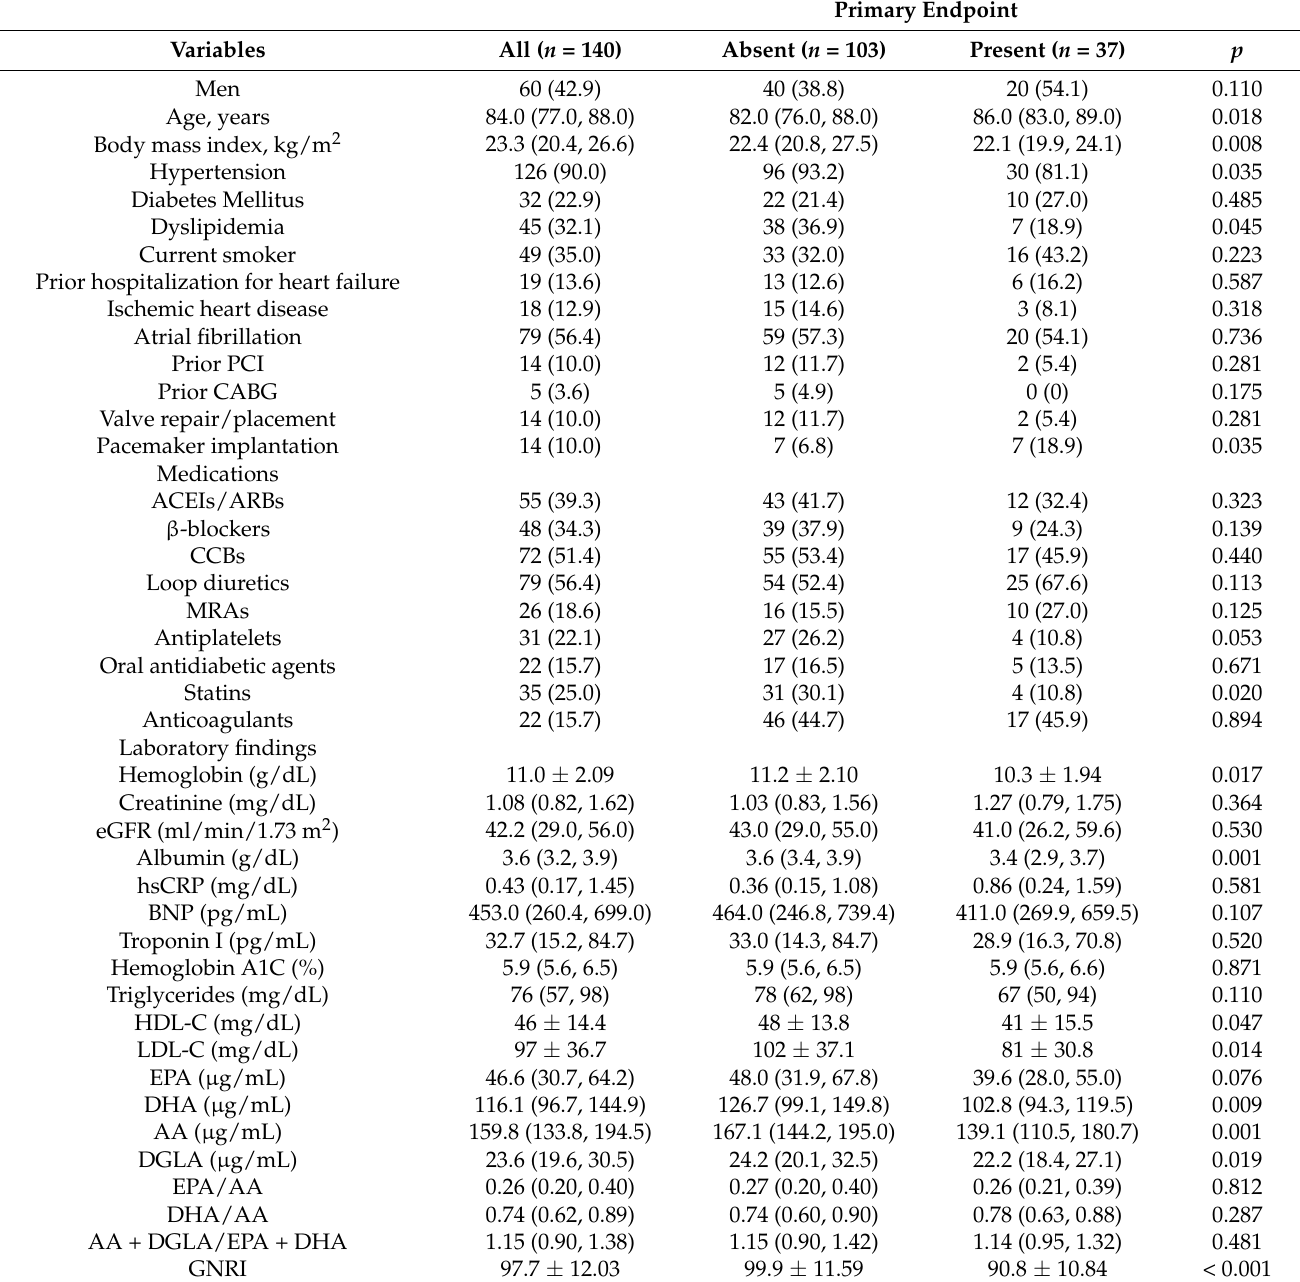
Table 1. Baseline characteristics according to the presence or absence of the primary